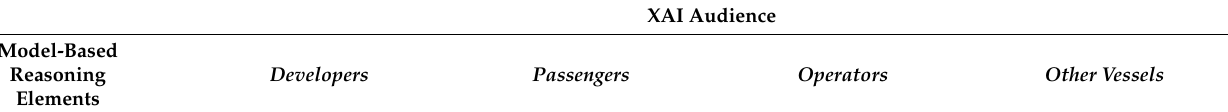
Figure 15. The virtual simulator based on Gemini open-source platform [46] allowed for immersive thought experimentation of operational design of milliAmpere2.